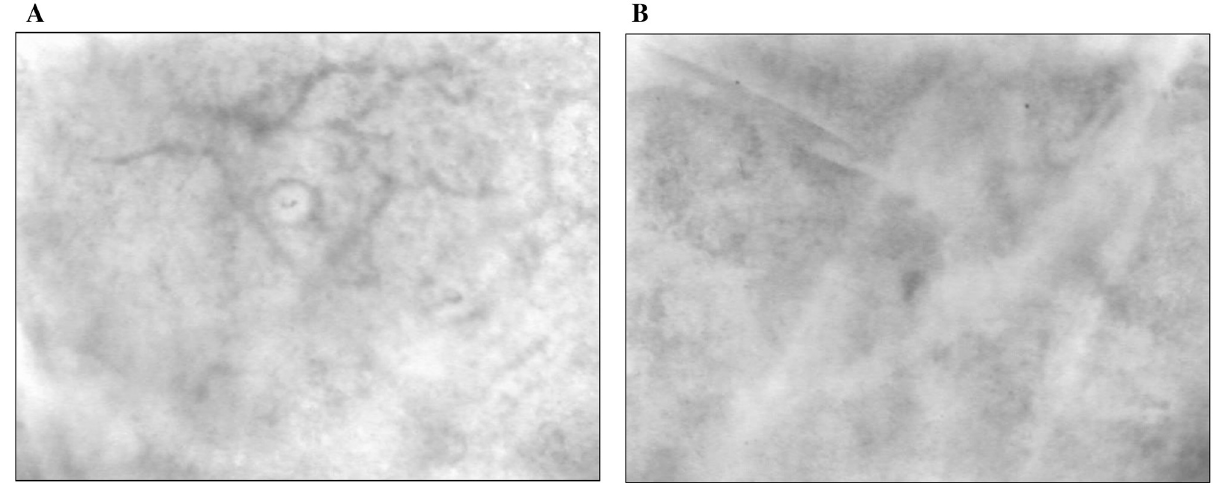
Fig 2. Sidestream dark field images of cutaneous microcirculation. Capillary blood perfusion in (A) normal skin (control) (B) Skin lesion (plaque) of the same tuberculoid leprosy patient.